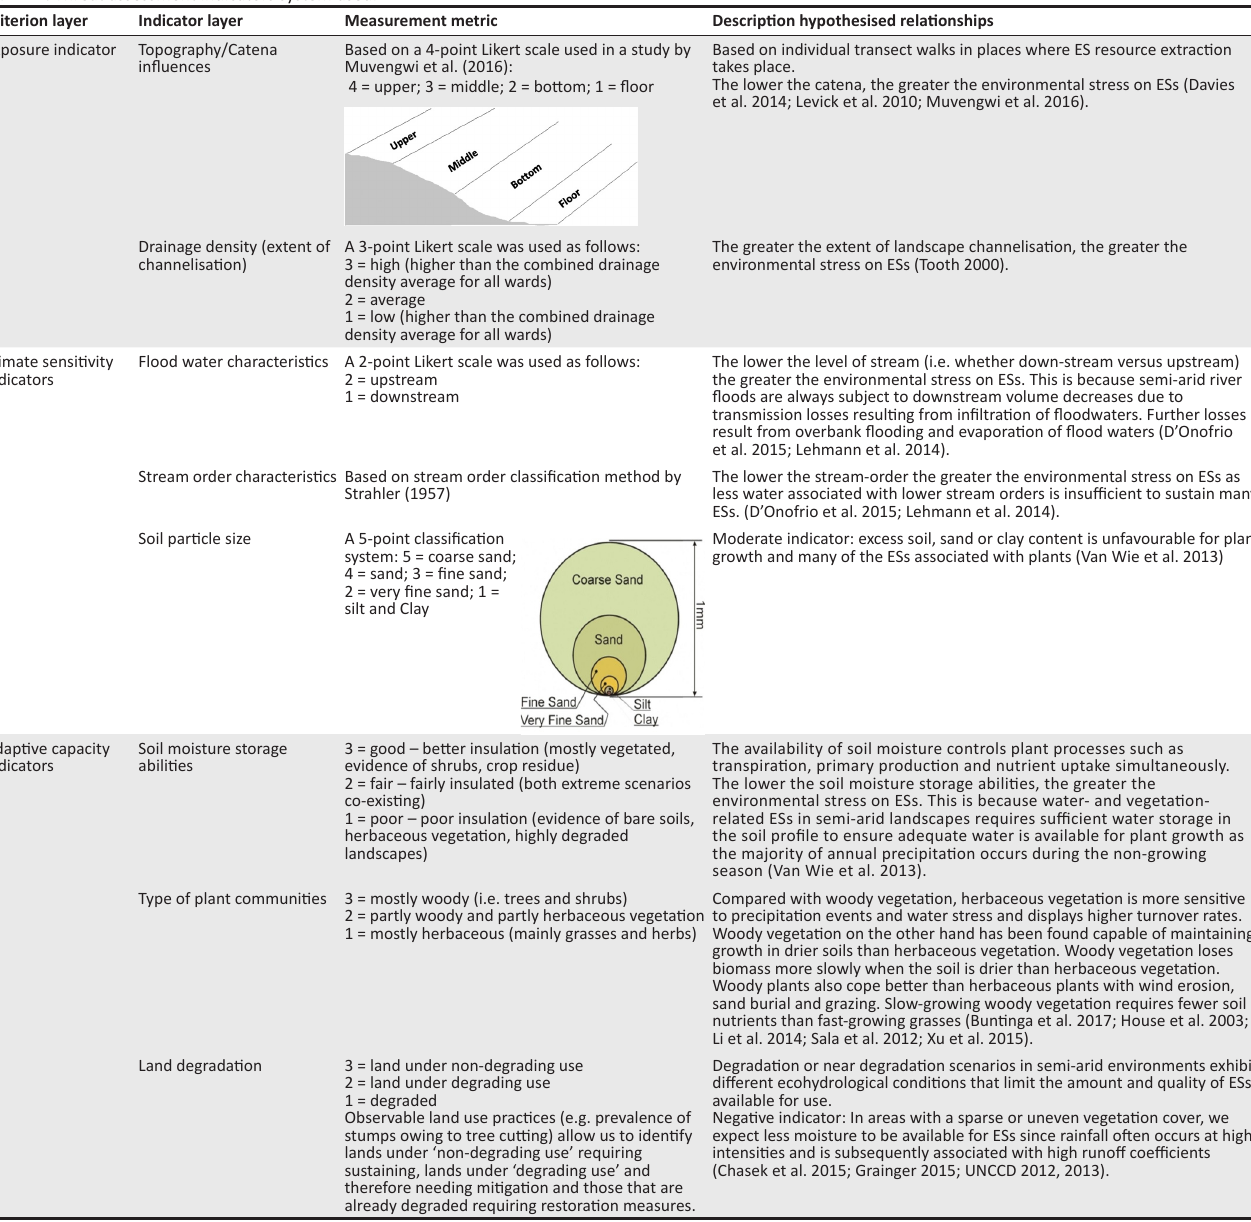
TABLE 1: Threat assessment indicators system used. Criterion